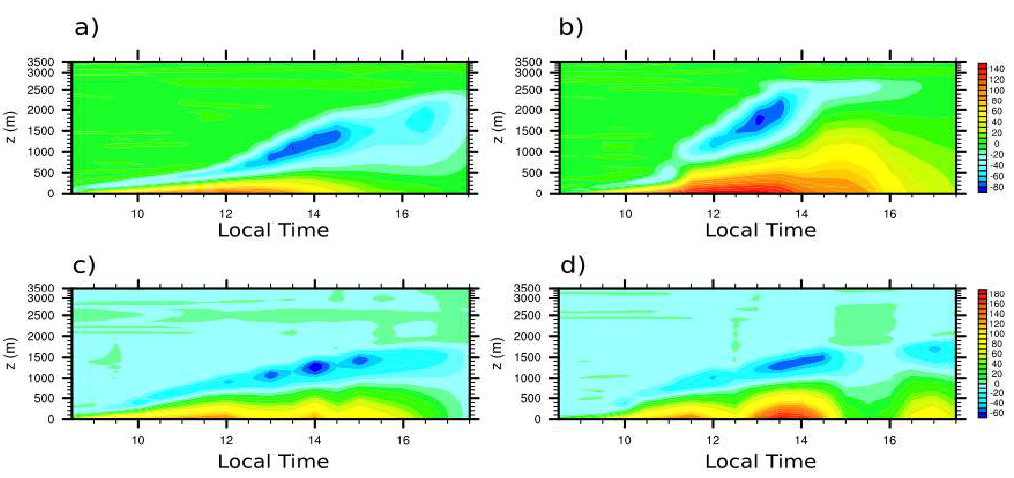
Figure 5. Time series of profiles of sensible heat flux over: FOR ( a , c ) ;and PAS ( b , d ) sites. During: DRY ( a , b ); and WET ( c , d ) seasons.